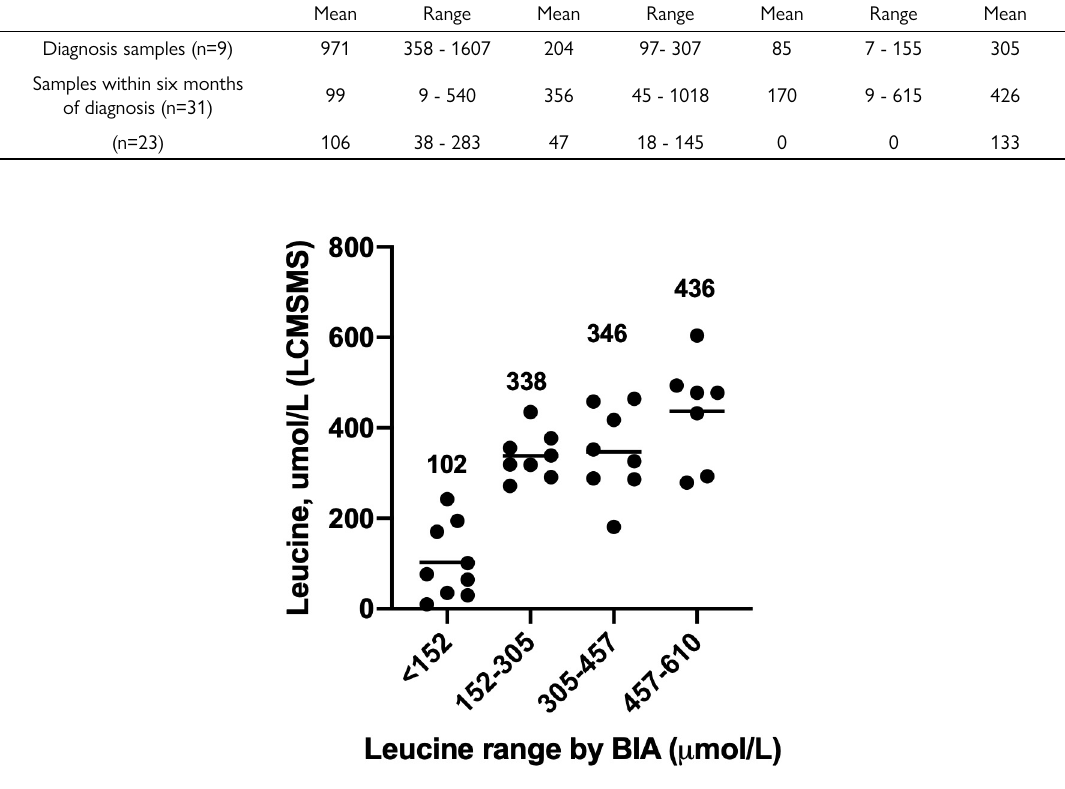
Figure 2. Comparison of Leu levels measured by BIA versus LC-MSMS. Thirty-two dried blood spot samples of MSUD patients in follow-up were analyzed by bacteria inhibition assay (BIA) and LCMSMS method for BCAAs. Average Leu values are shown for each range of values analyzed by